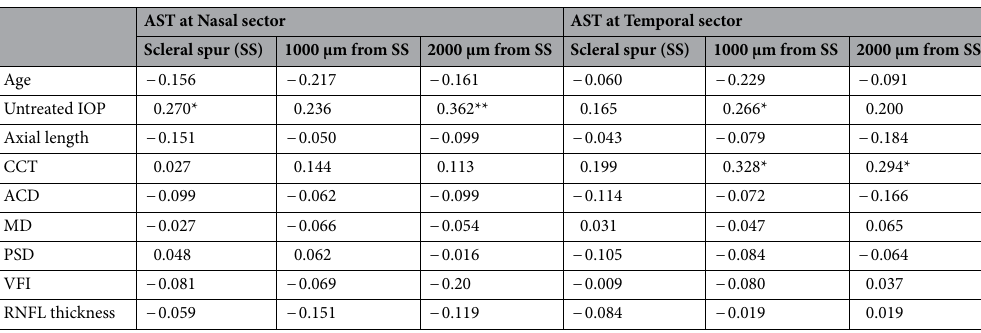
Table 2. Correlation between the anterior scleral thickness (AST) and other ocular factors. IOP intraocular pressure, CCT central corneal thickness, ACD anterior chamber depth, MD mean deviation, PSD pattern